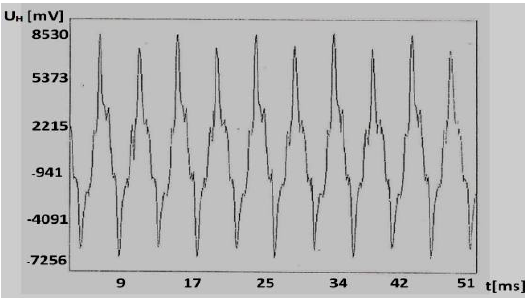
Figure 11. Hall voltage versus time for efficient starter, Hall sensors fixed on the rotor, unloaded starter.